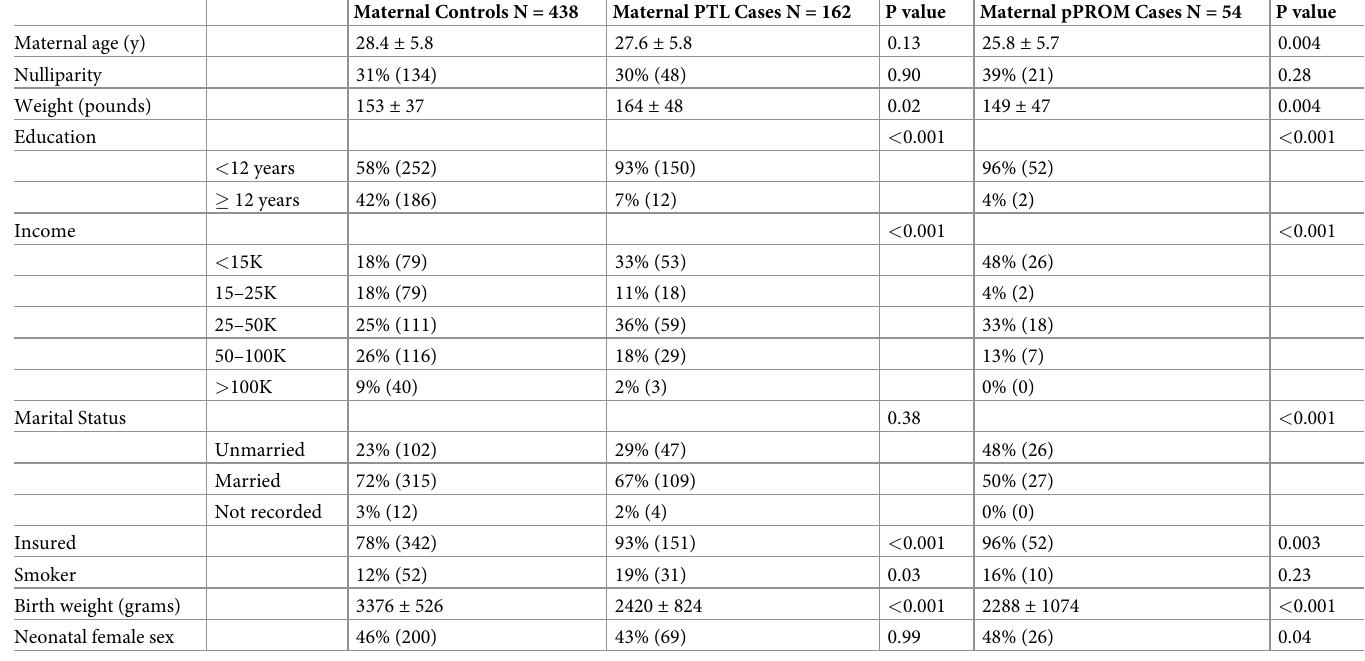
Table 2. Baseline characteristics of maternal cases and